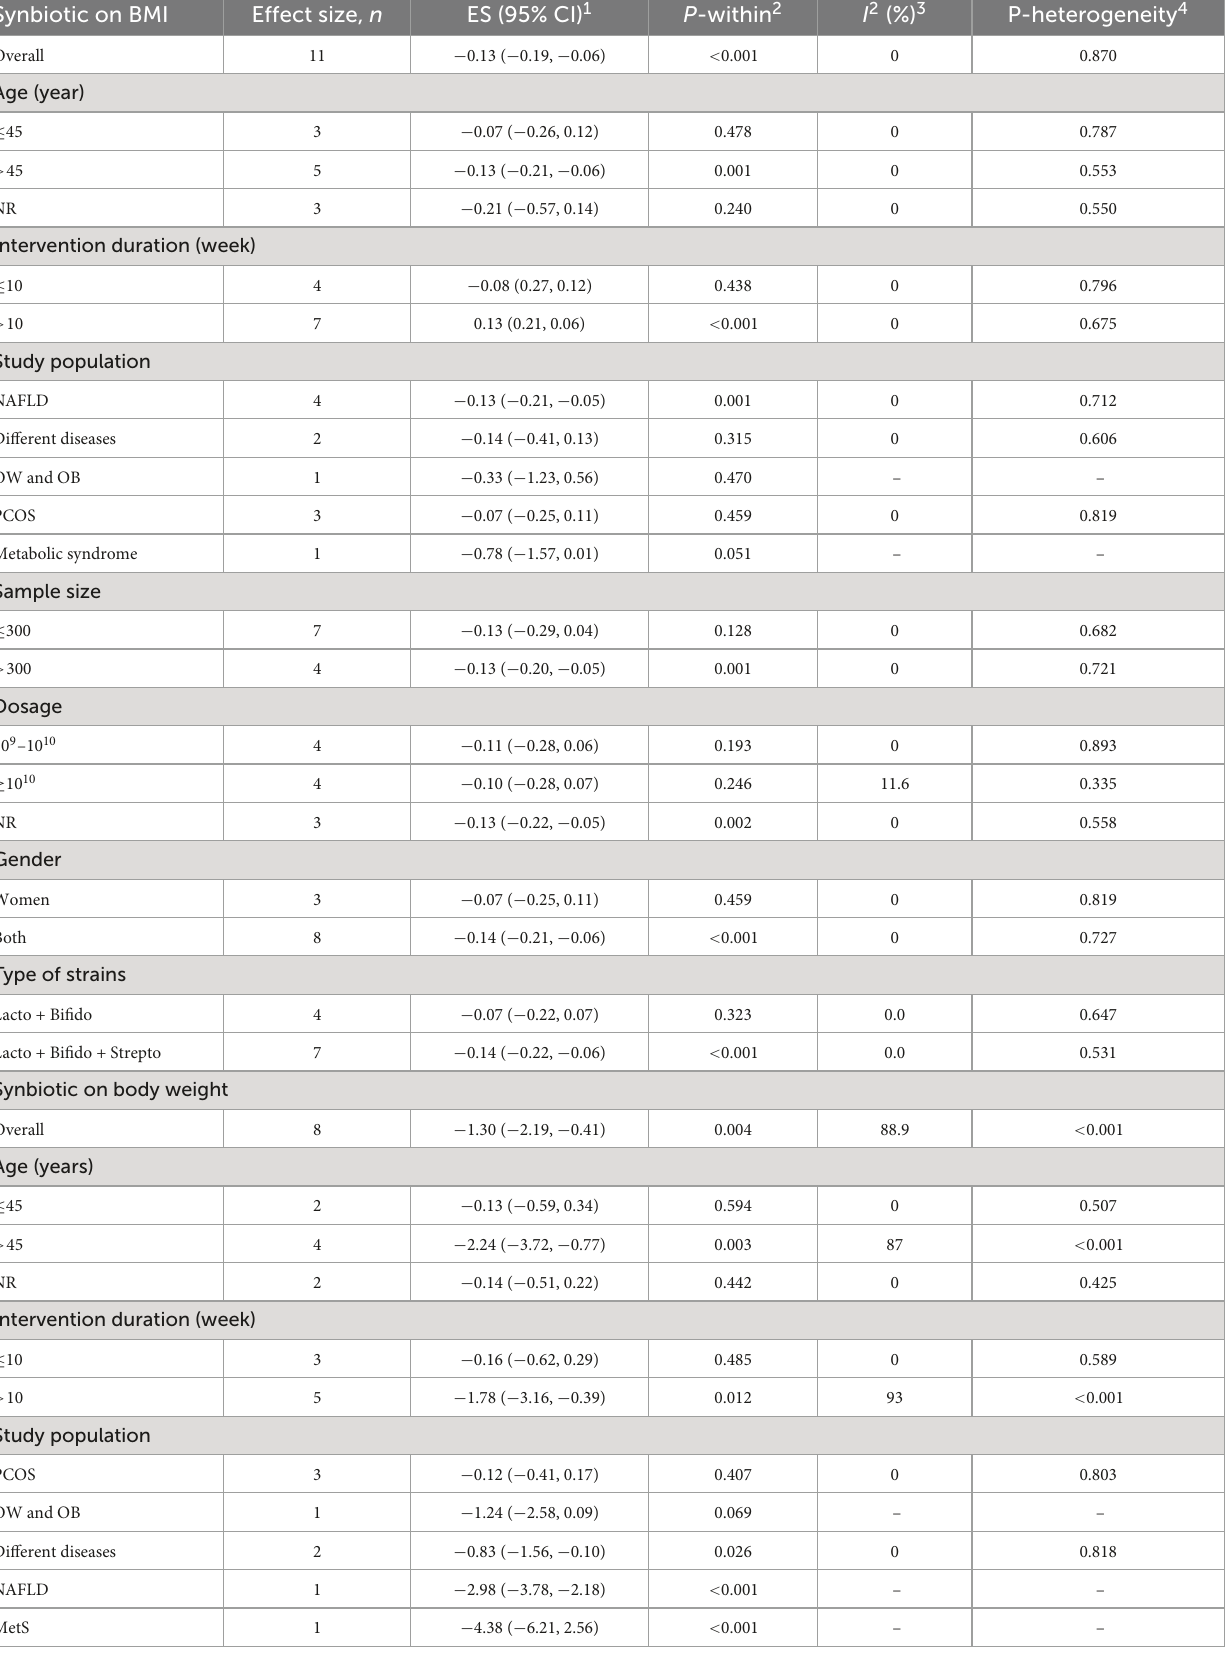
TABLE 3 Subgroup analyses for the effects of synbiotic supplementation on obesity. Synbiotic on BMI Effect size, n ES (95% CI)